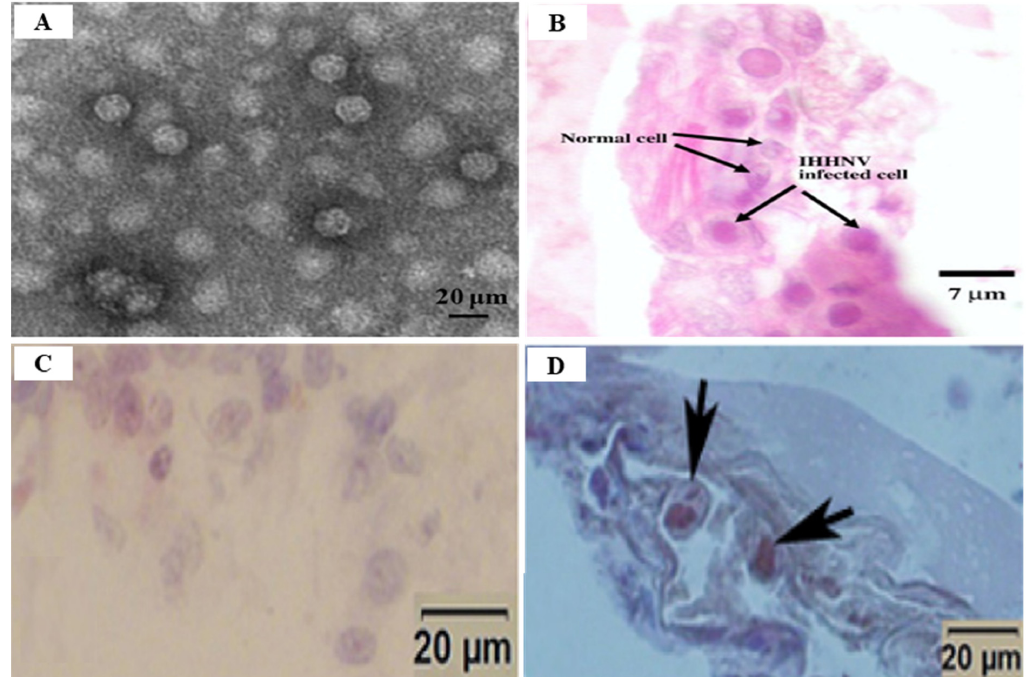
Figure 11. Electron microscopy and histological analysis of the changes in shrimp with infectious hypodermal and hematopoietic necrosis virus (IHHNV). ( A ) Electron microscopy of negatively stained IHHNV VLPs under self-assembly and disassembly conditions in Penaeus vannamei ; ( B ) Cowdry type A eosinophilic inclusion of IHHNV in a nucleus of subcuticular epithelial cells of the pleopod of P. monodon (H & E, 1000×); ( C ) Histological detection of Procambarus clarkii gills negative to IHHNV detected by PCR. The gill cells were normal, no hypertrophied nucleus was observed; ( D ) Histological detection of P. clarkii gills positive to IHHNV detected by PCR. Several hypertrophied nuclei (arrow) were observed. (( A ) Reprinted from Journal of Invertebrate Pathology, Vol. 166, Zhu,